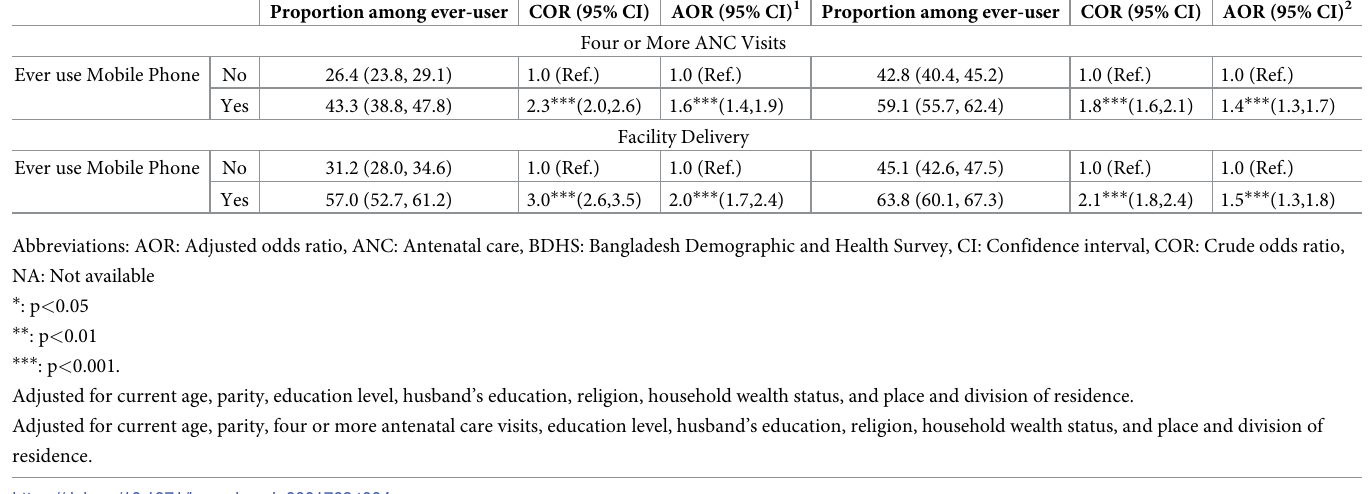
Table 4. Association of mobile phone using for pregnancy-related causes with at least 4 ANC visits and facility delivery.